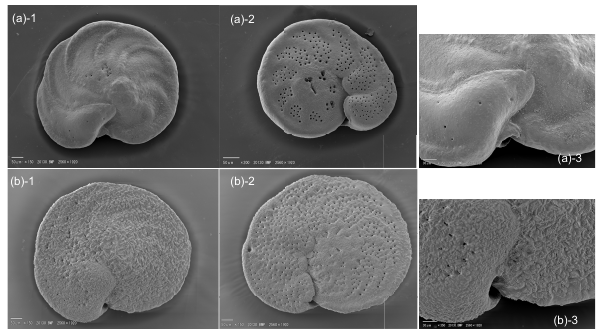
Figure 5. SEM images of C. wuellerstorfi type A: sensu stricto (a) - 1 umbilical side, (a) -2 spiral side, (a) -3 aperture and C. wuellerstorfi type B (b) -1 umbilical side, (b) -2 spiral side, and (b) -3 aperture.